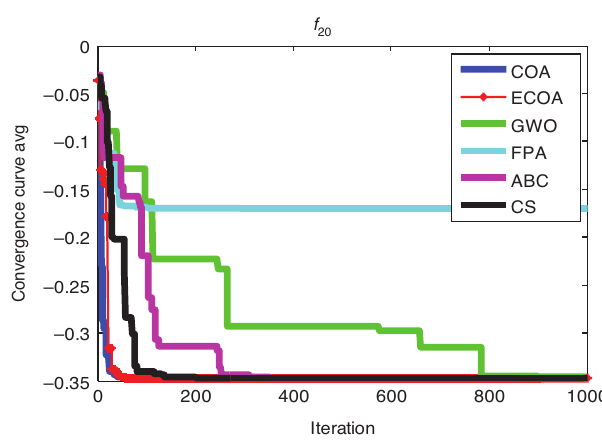
Figure 39: D = 4, Evolution Curves of Fitness Value for f